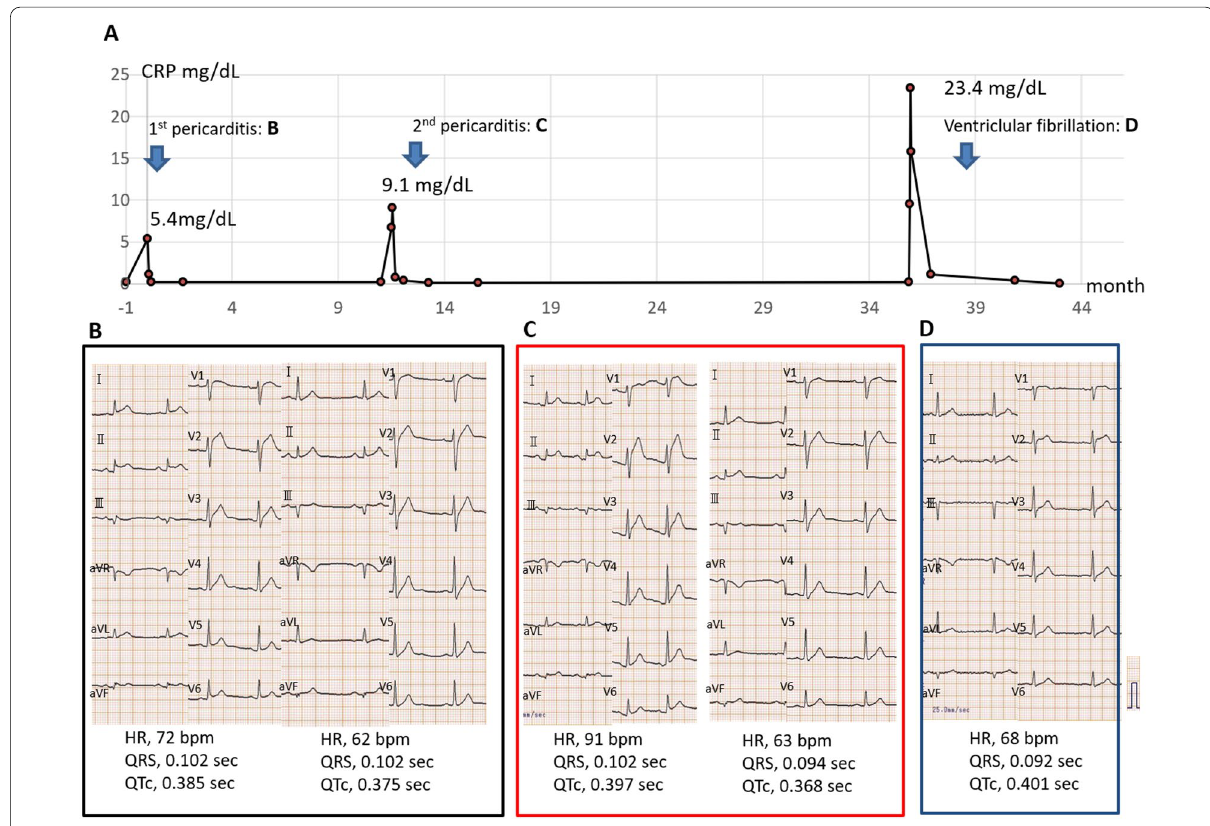
Fig. 3 Time course of C-reactive protein level in preceding two episodes of pericarditis with corresponding ECG changes. a Time course of C-reactive protein level in preceding two episodes of pericarditis and ventricular fibrillation episode. b ECG of first pericarditis, in which left side shows the ECG on admission day, and the right side shows that on 6th day. c ECG of second pericarditis, in which left side shows the ECG on admission day, and the right side shows that on 6th day. d ECG of five months after ventricular